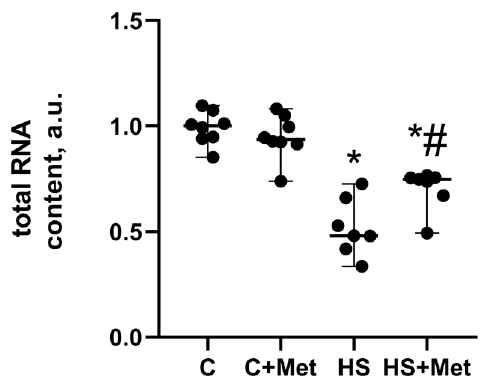
Figure 7. Effect of metformin pre-treatment on the total RNA content in rat soleus muscle. Total RNA content was normalized per mg of muscle tissue. C, vivarium control, C+Met, vivarium control + metformin pre-treatment, HS, 7-day hindlimb suspension, HS+Met, metformin pre-treatment + 7-day hindlimb suspension. Scatter dot plot indicates median values, and the whiskers represent minimum and maximum values; n = 7–8/group. *: p < 0.05 vs. C, #: p < 0.05 vs. HS.